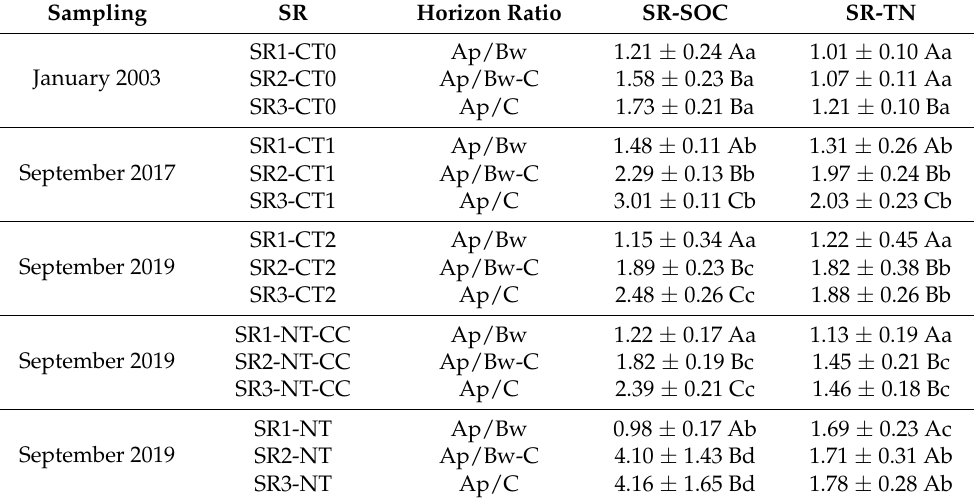
Table 5. Stratification ratio of soil organic carbon and nitrogen (average ± SD) in a Mediterranean olive grove. Initial situation (January 2003), intermediate situation (September 2017), and final situation (September